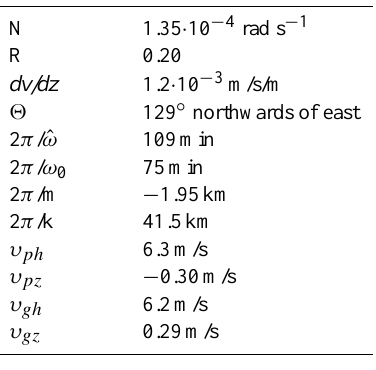
Table 2. The characteristics of gravity wave estimated by the hodo- graph analysis (Esrange radar data).